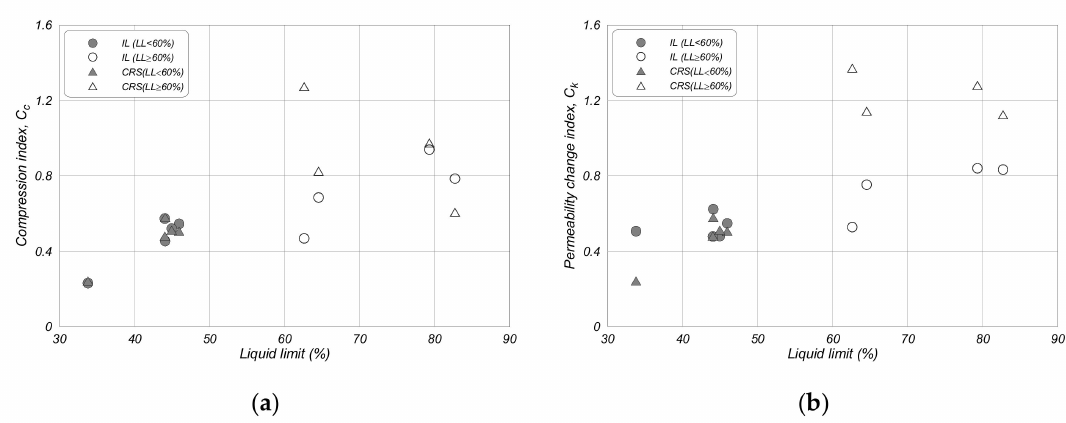
Figure 5. Consolidation properties of Gwangyang region soil: ( a ) liquid limit (LL)-compression index (C c ); ( b ) liquid limit (LL)-permeability change index (C k